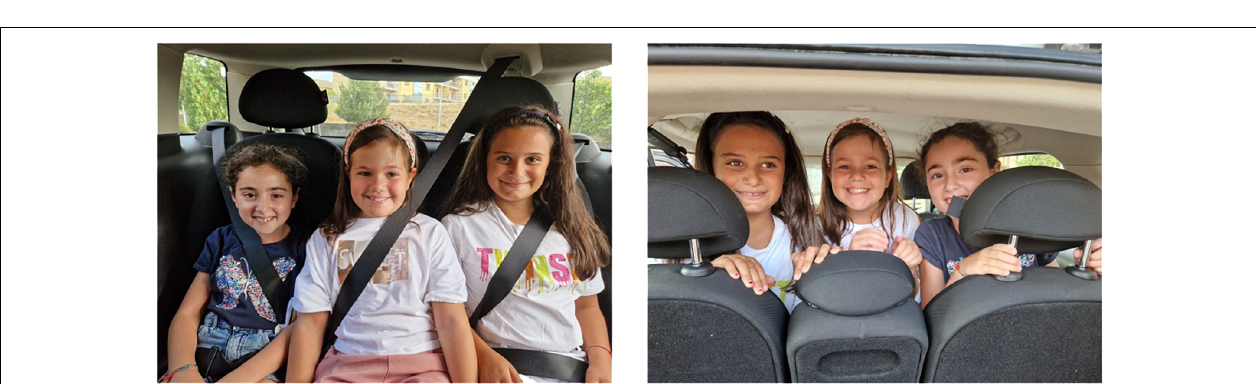
FIGURE 5 | Road speed limit. Available at: https://www.pitstopadvisor.com/news/tachimetro-auto-effettiva-velocita/ and https://www.passiamo.lt/ll-llmite-dl-velocita-deve-ripetersl-dopo-ogni-intersezione-cass-civ-20-maggio-2014/.